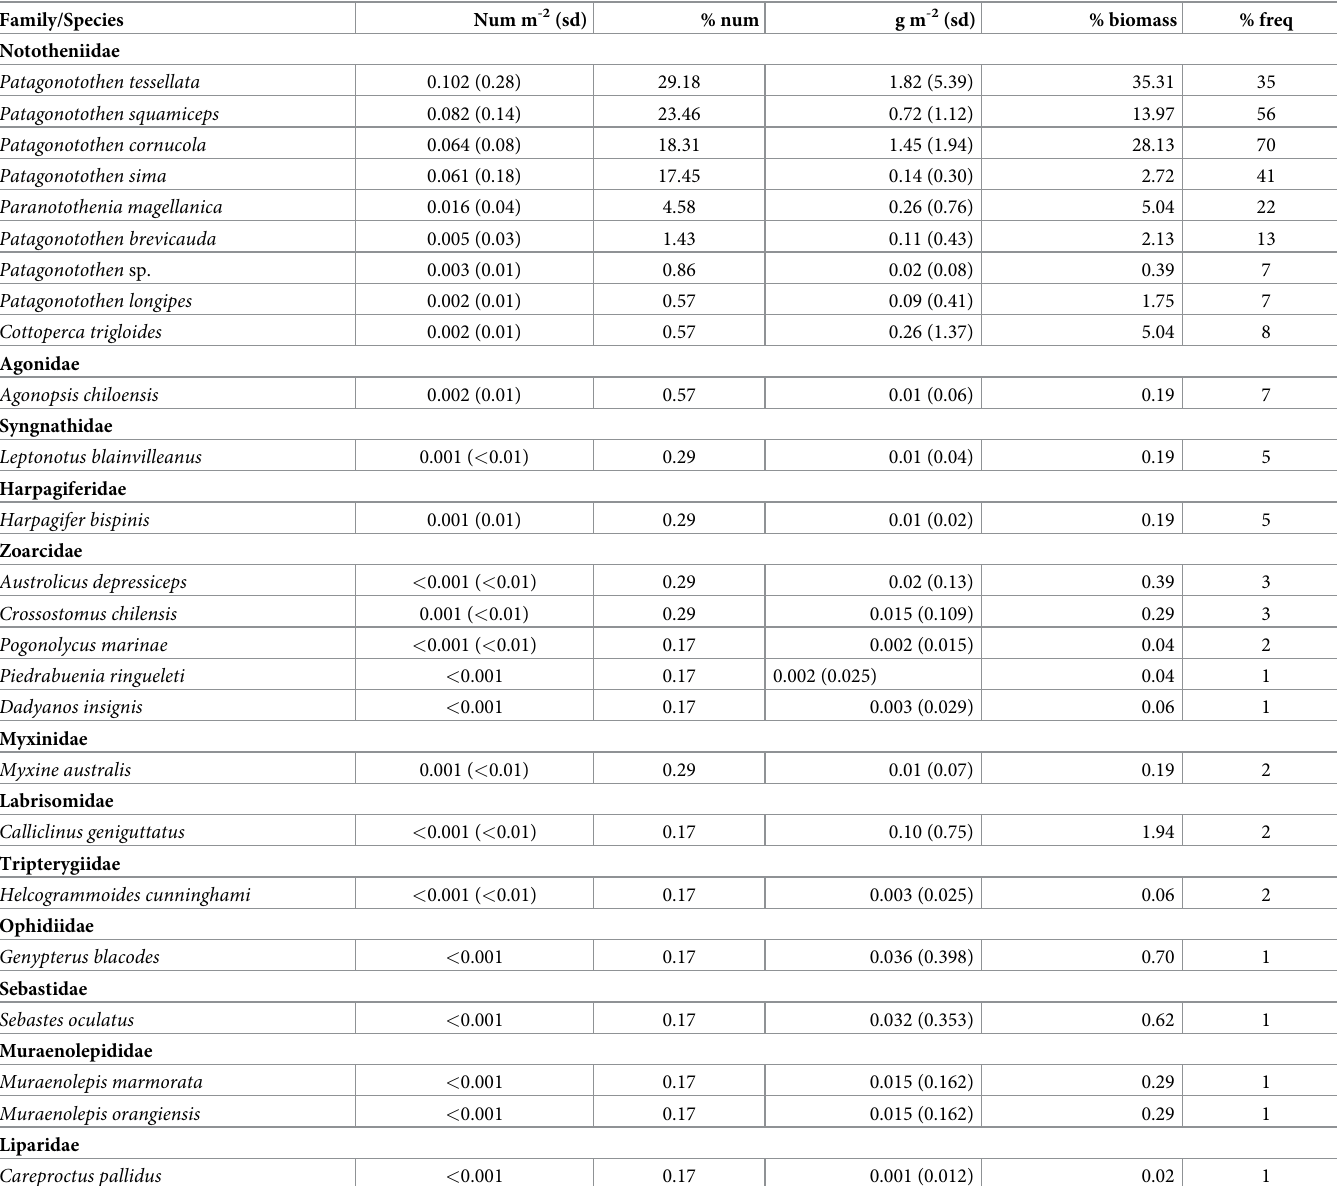
Table 1. Summary statistics for species observed on quantitative